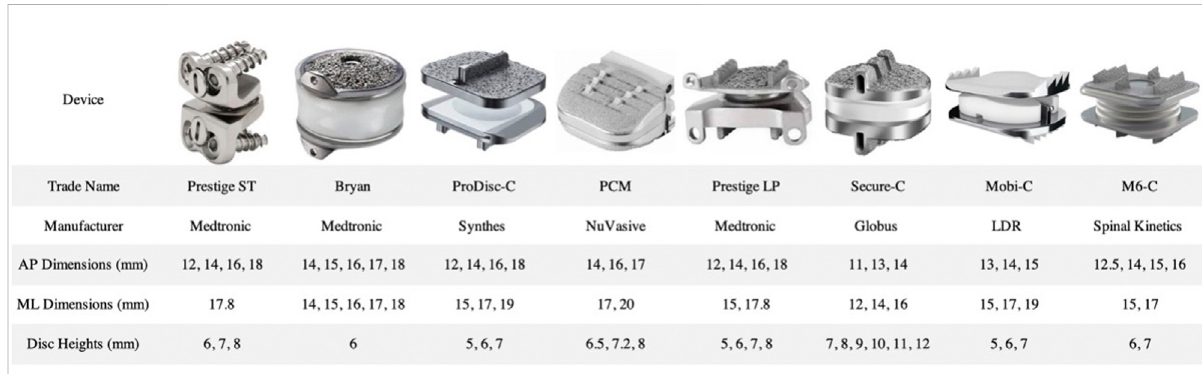
FIGURE 2 Prosthesis information: Prestige ST (10), Bryan (Food and Drug Administration, 2009), ProDisc-C (12), PCM(13), Prestige LP (14, 15), Secure-C (16), Mobi-C (17, 18), M6-C (19).